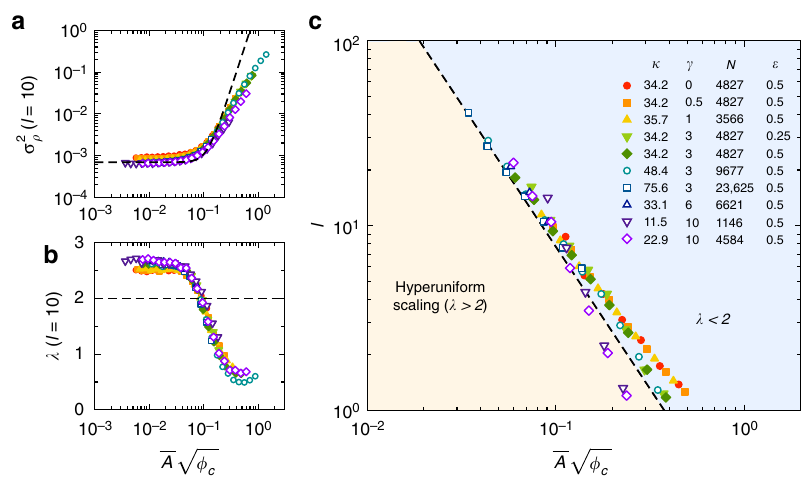
Fig. 6 Self-organized hyperuniformity. a Variance of the number density, σ 2 ρ ð ‘ Þ , for sampling windows of size ‘ ¼ 10. The data over a wide range of parameters are collapsed when plotted versus A moderate velocities are captured by Eq. (8) for the effect of vertical concentration gradients (dashed line). b Magnitude of the local scaling exponent, λ , measured at ‘ ¼ 10. At this length scale, hyperuniform scaling ( λ > 2) is observed for A Hyperuniformity emerges below a fi nite threshold value of A , de fi ned as the shortest length scale where the local scaling exponent λ of the variance σ 2 ρ ð ‘ Þ becomes shallower than 2. Dashed line: Symbols: ‘ H Phase boundary from our theory with no free parameters, Eq. expressing in terms of A , we get σ 2 ρ ð ‘ Þ